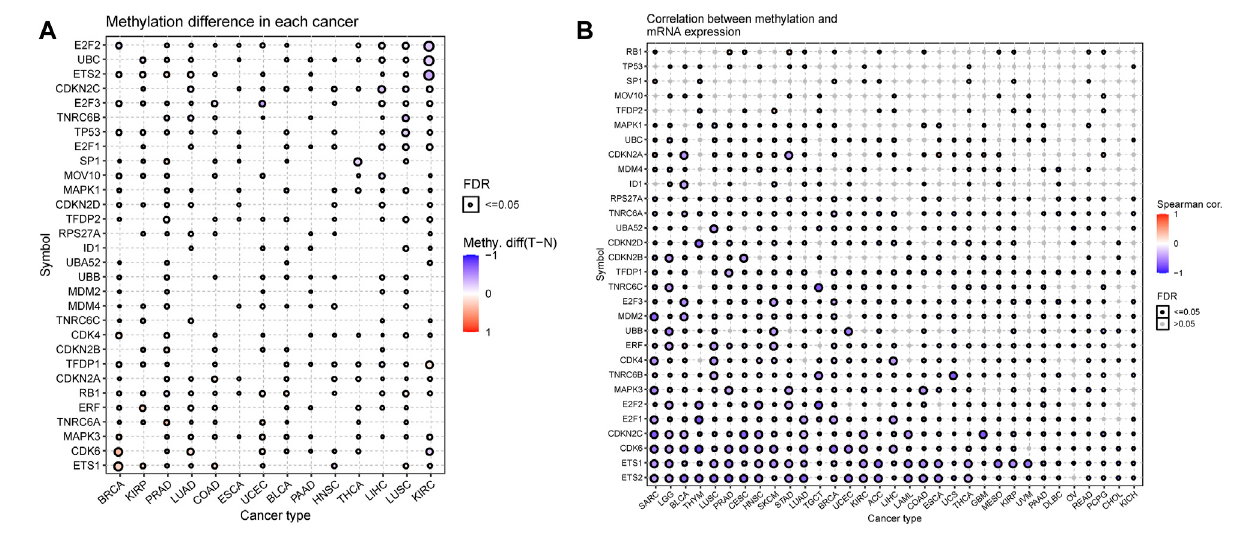
FIGURE 8 | DNA Methylation analysis of senescence-related genes (SRGs). (A) Methylation differences of SRGs in tumors. The p-value of the false discovery rate (FDR)andthemethylationdifferencesareindicatedbythebubblecolorandbubblesize.Thebubblecolorfrombluetoredrepresentsthemethylationdifferencebetween tumorandnormal.ThesizedotispositivelycorrelatedwithFDRsigni fi cance. (B) CorrelationsofmethylationwithSRGs ’ expression.Thebluebubblesrepresentnegative correlations. The red bubbles represent positive correlations; the deeper the color, the higher the correlation. The bubble size is positively correlated with the signi fi cance of FDR. The black outline border indicates FDR ≤ 0.05 (Spearman correlation, the dot was fi ltered by FDR ≤ 0.05).